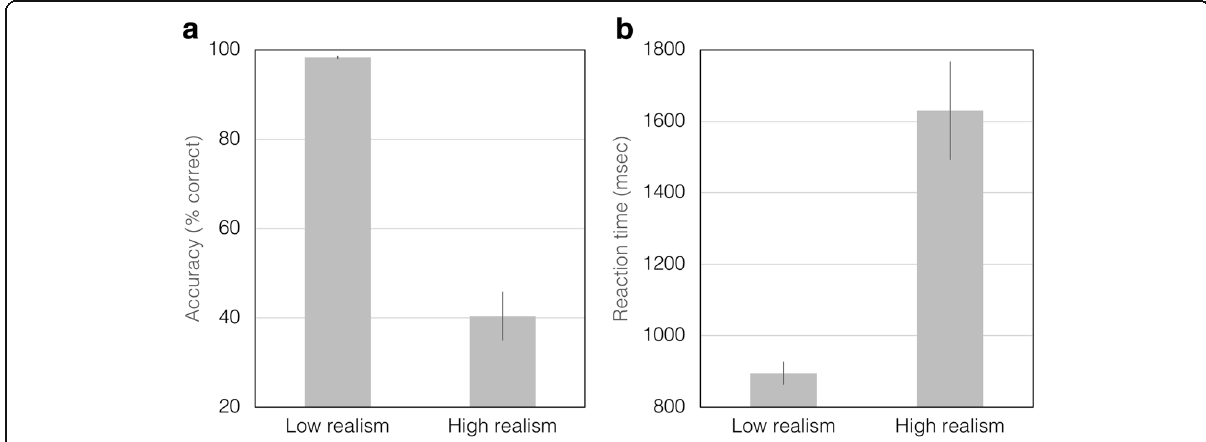
Fig. 3 Mean accuracy rates ( a ) and correct reaction times ( b ) across participants as a function of mask condition in Study